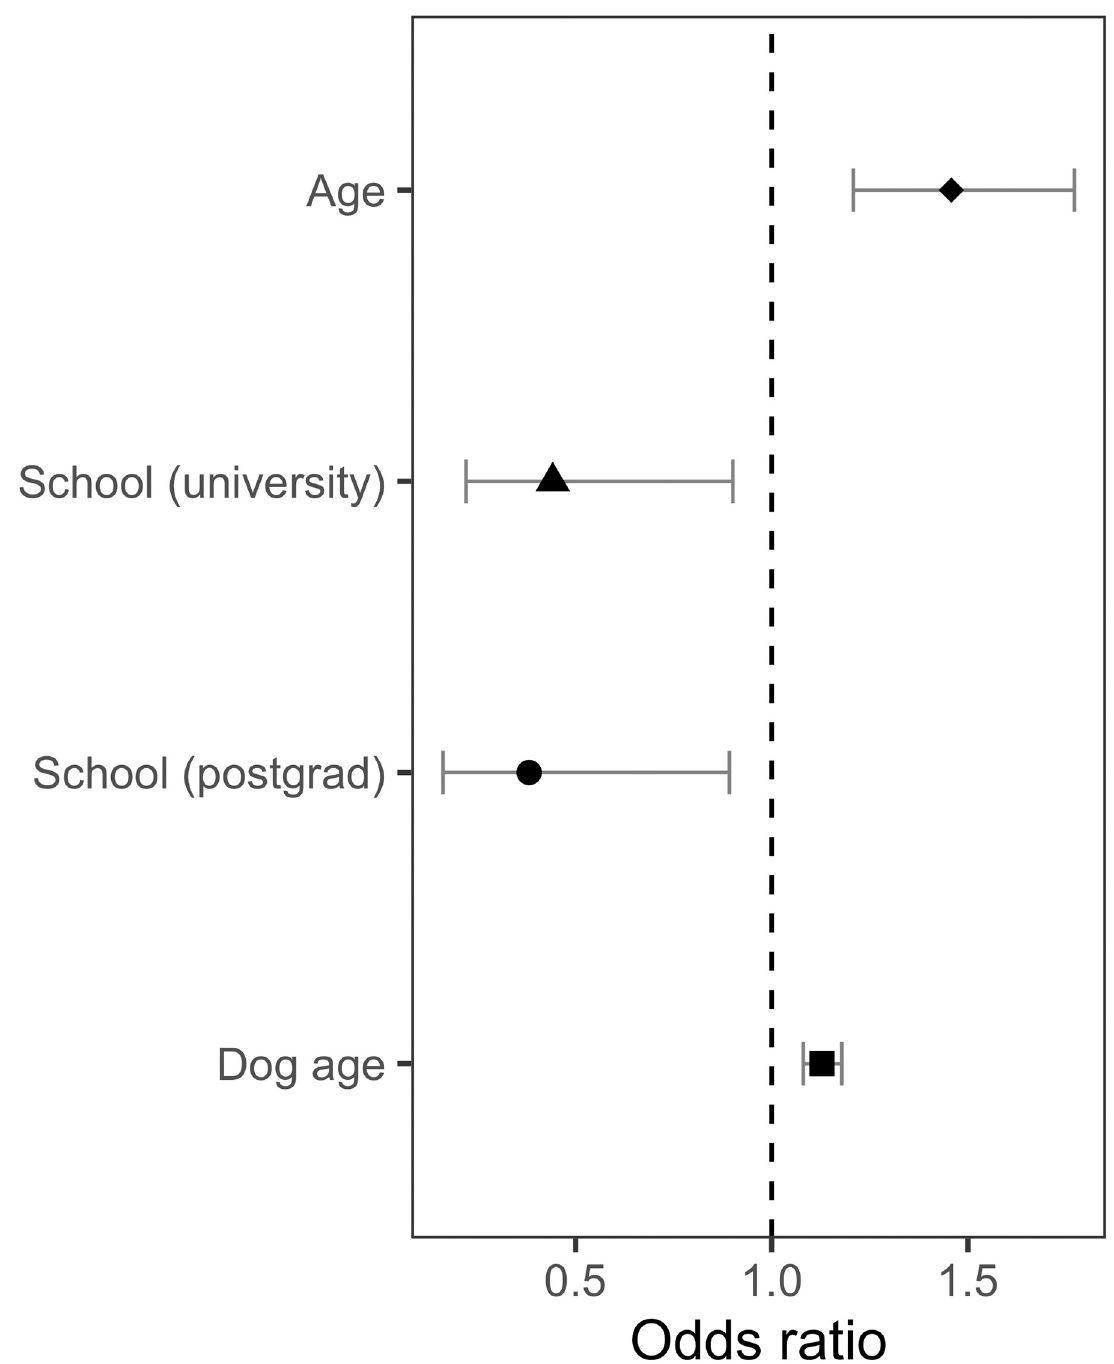
Fig 2. Statistically significant owner and dog parameters on the internet help outcome. Internet help outcome odds predicted by statistically significant predictor variables: owner age (P < .001), university-educated owners (P = .022), postgraduate-educated owners (P = .026), and dog age (P < .001), calculated by the logistic regression model.